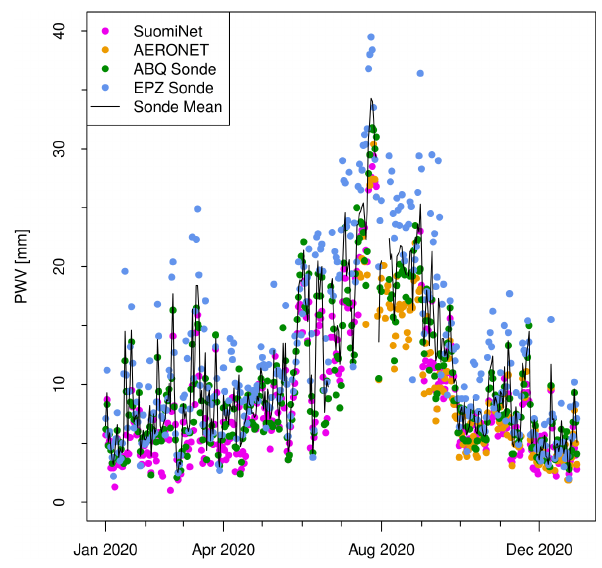
Figure 3. Time series plot showing daily mean SuomiNet, AERONET, and ABQ and EPZ radiosonde observations of PWV for the year 2020 (color symbols), with the weighted mean of the radiosonde measurements indicated by the solid line.